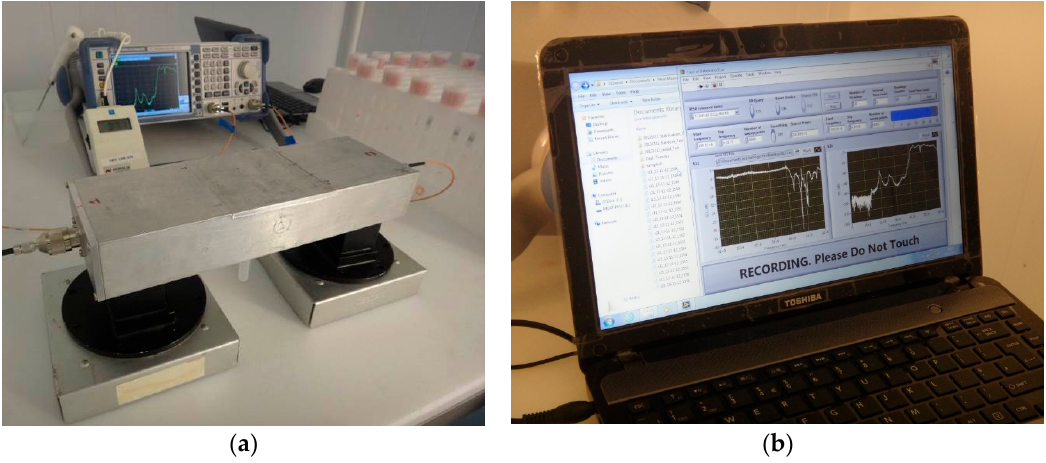
Figure 5. ( a ) Experimental setup showing the microwave cavity connected to a Rohde and Schwarz Vector Network Analyzer; and ( b ) a bespoke LabVIEW ® interface capturing spectral